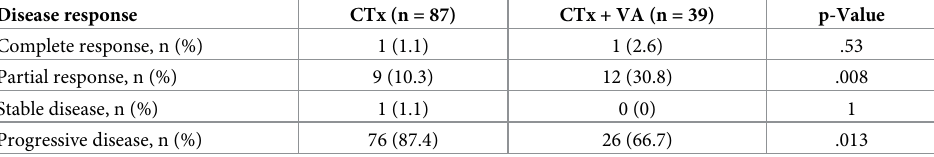
Table 5. Tumor response after treatment with CTx with or without VA therapy (subgroup, n =